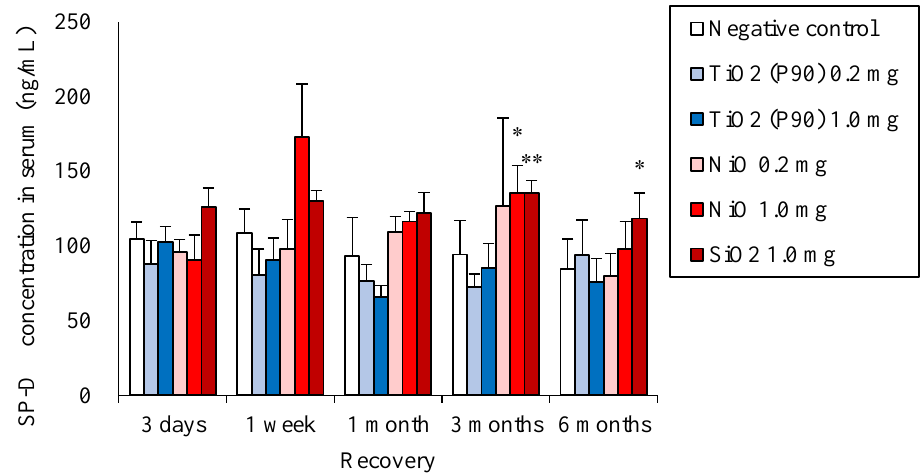
Figure 6. SP-D concentration in serum at each time point after intratracheal instillation of nanomaterials. Error bars represent mean ± SD for n = 4–5/group. Asterisks indicate significant differences compared with each control (Analysis of variance and Dunnett’s test) (* p < 0.05, ** p < 0.01). An average of negative controls in all experiments at each time point showed a single bar of negative control.